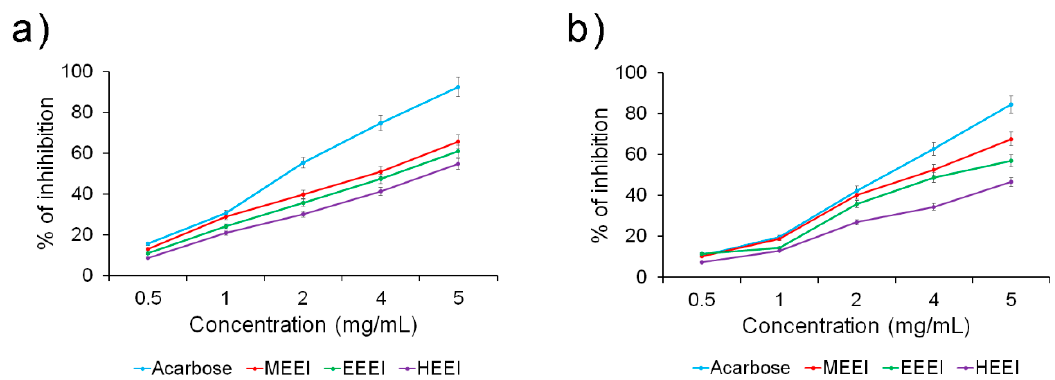
Figure 3. Antidiabetic capacity of different solvent extracts from Enteromorpha intestinalis as determined by ( a ) α -amylase, and ( b ) α -glucosidase inhibitory activity assays. Table 5. IC 50 values (in µ g/mL) of the antidiabetic activity of the extracts of Enteromorpha intestinalis . Assay